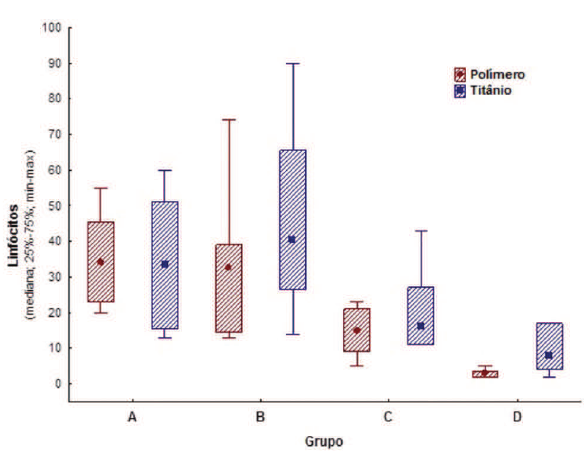
definidoFig. Fig. 5 – Análise quantitativa de células gigantes conforme grupo